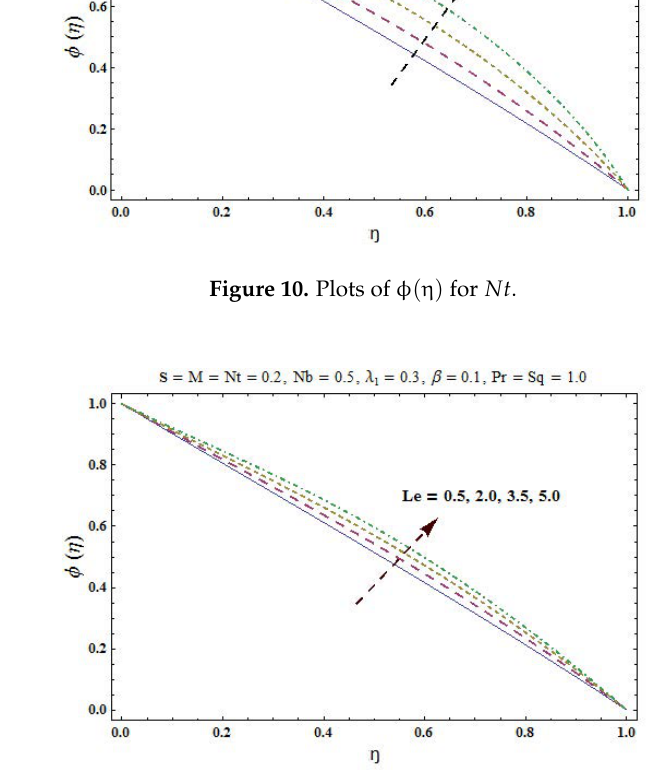
Figure 11. Plots of φ ( η ) for Le